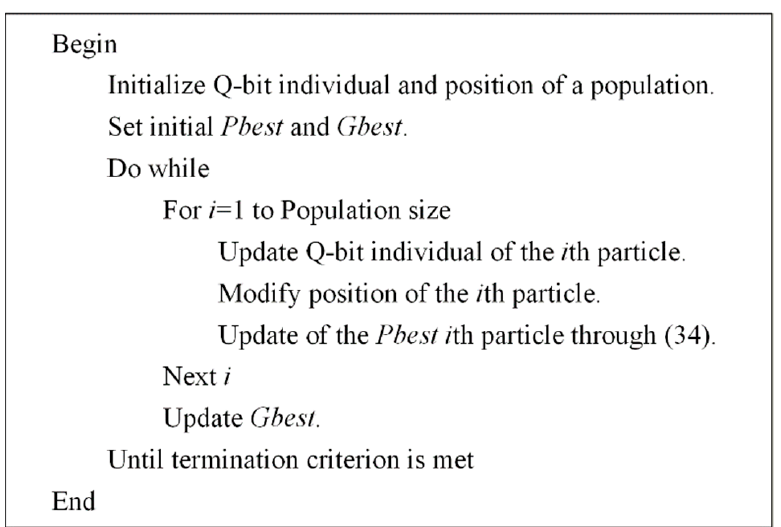
Figure 3. Pseudo − code of the QB − PSO based solving method for the problem of communication Figure 3. Pseudo-code of the QB-PSO based solving method for the problem of communication structure structure optimization.